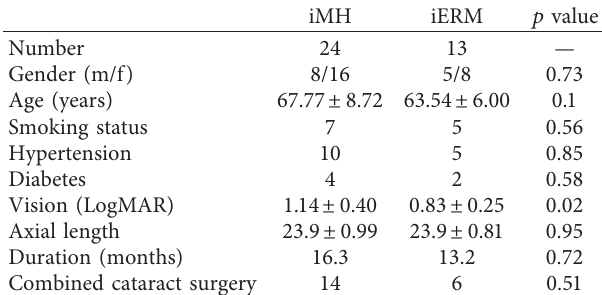
Figure 2: Flow diagram of patients included in this study. Table 1: Clinic characteristics of patients with iMH and